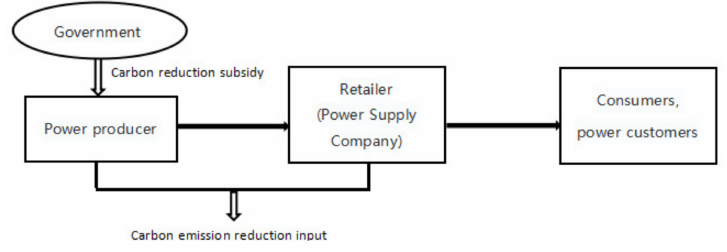
Figure 2. Schematic diagram of model C.